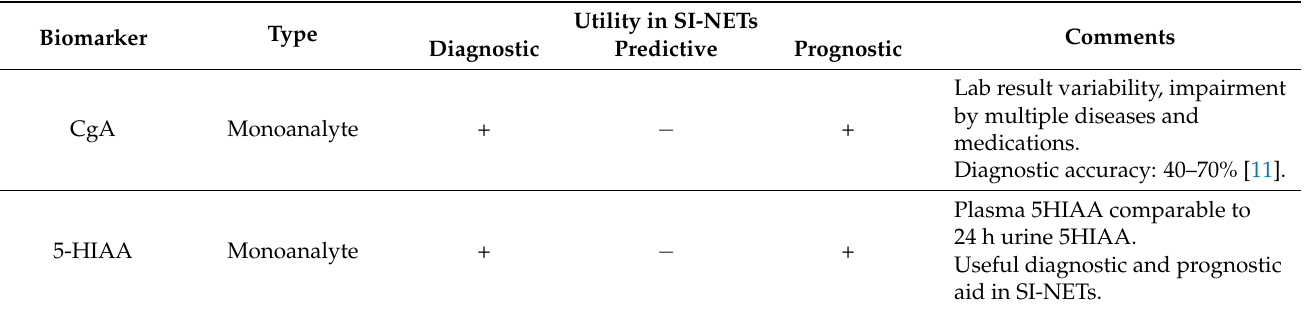
Figure 1. Schematic representation of biomarkers used in SI-NET. Secretory products include biomarkers such as Chromogranin A, 5-hydroxy-indole acetic acid, pancreastatin etc.; mRNA, mes- senger RNA, miRNA, microRNA, SI-NET, small intestine neuroendocrine tumor; ctDNA, circulating tumor DNA. Table 1. Overview of SI-NETs